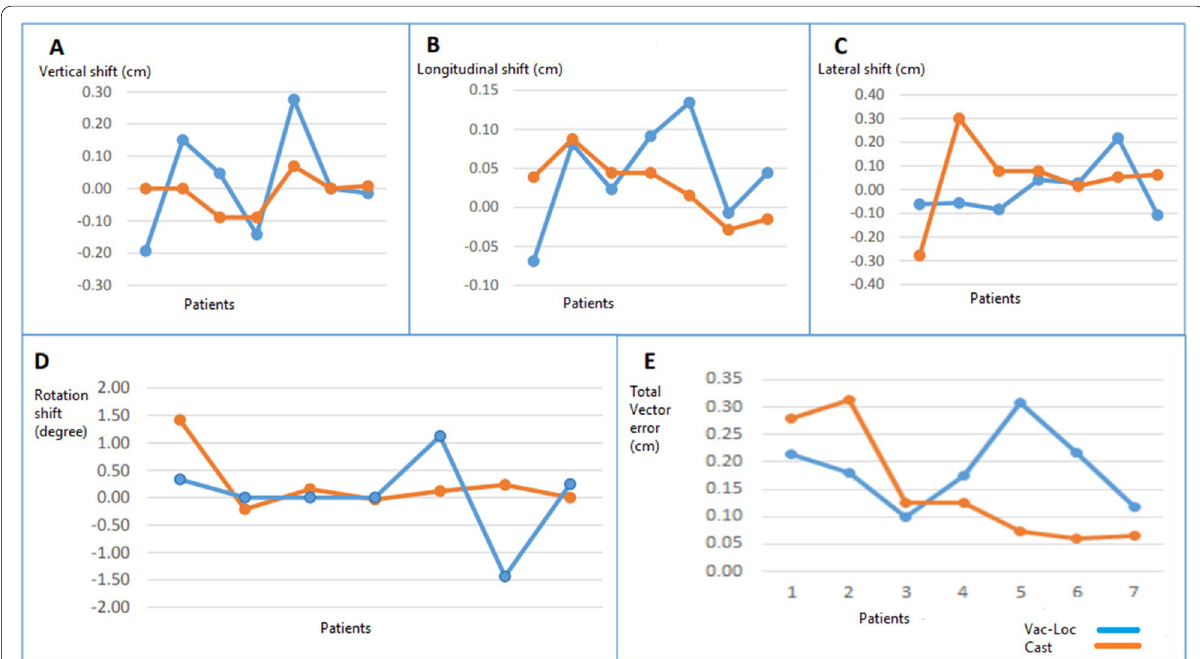
Fig. 4 Comparison of Vac‑Loc ™ and thermoplastic cast; Translational and angular shifts. The figure shows comparison of the mean translational, angular and Total Vector Error (TVE) displacements for each patient immobilized using Vac‑Loc ™ and thermoplastic cast. The mean value for each